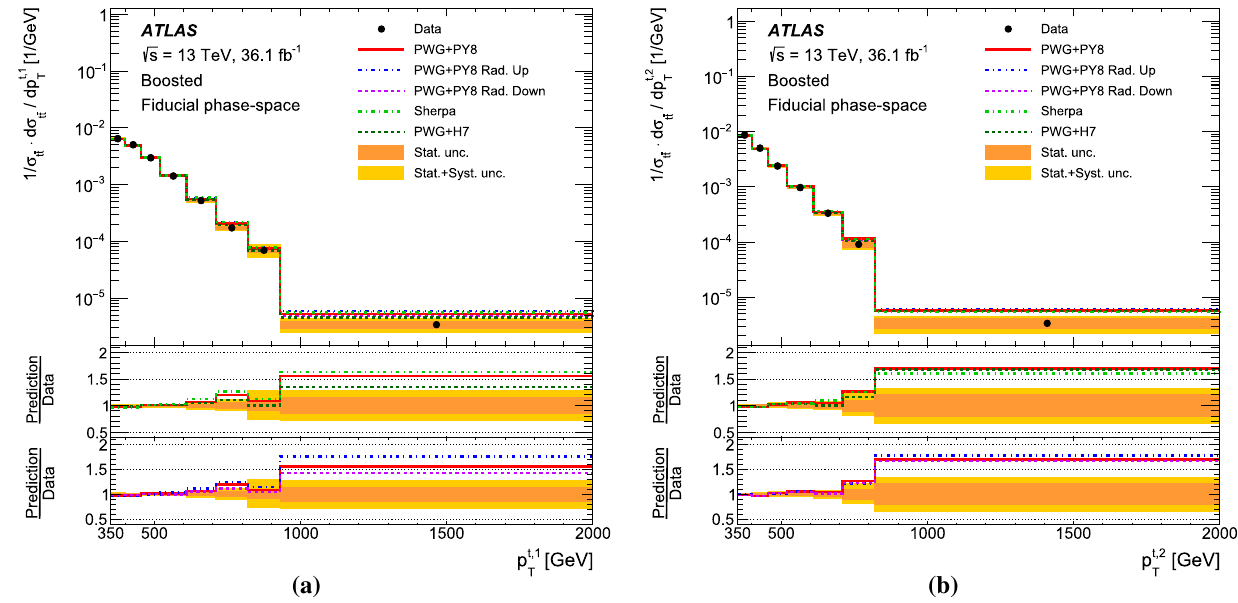
Fig. 38 Particle-level normalised differential cross-sections as a func- tion of the transverse momentum of a the leading and b the subleading topquarkintheboostedtopology,comparedwithdifferentMonteCarlo